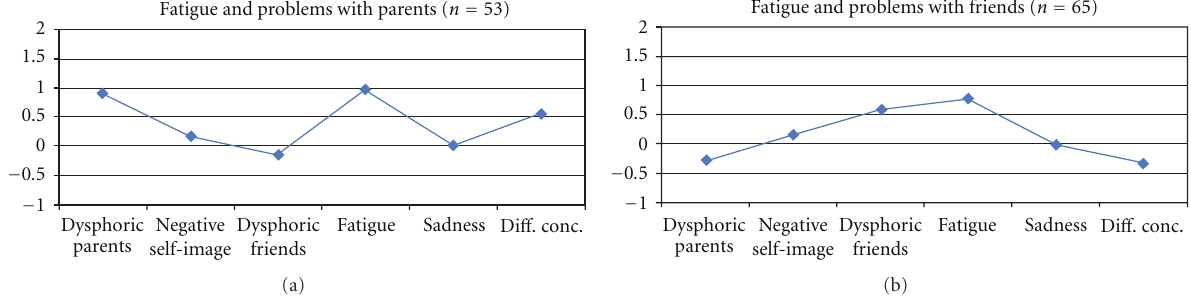
Figure 2: Two- and three-problem clusters. Profiles in terms of z -scores (where z = 0 corresponds to the whole sample’s mean on each subscale). Negative self-cluster ( n = 71)